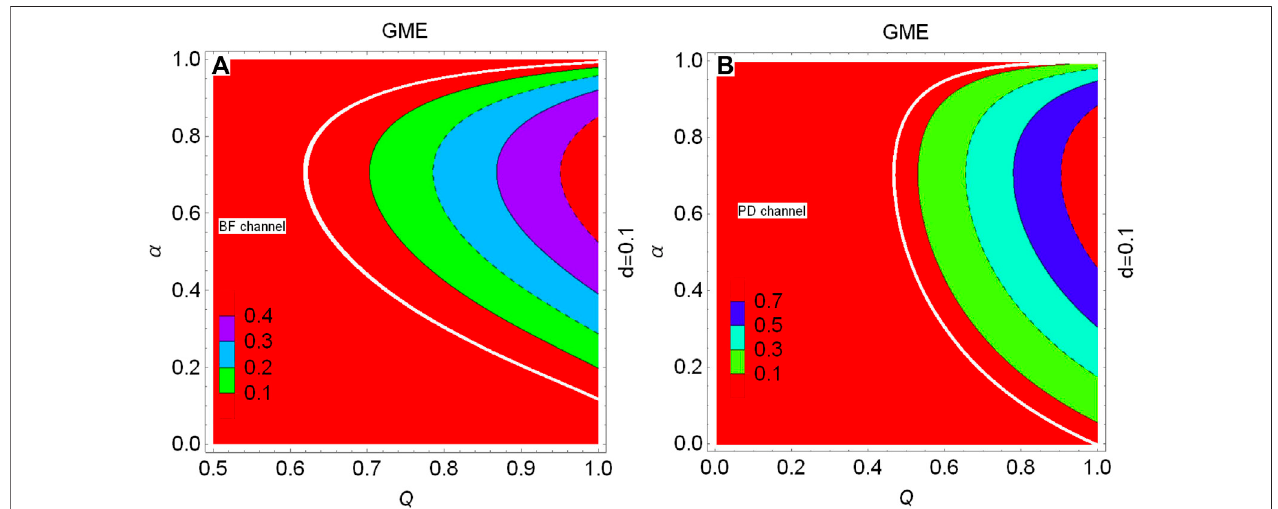
FIGURE 7 | (Color online) Contour plot of GME versus the state parameters Q and α for d (cid:2) 0 . 1 in the different noisy channels. (A) BF channel. (B) PD channel.